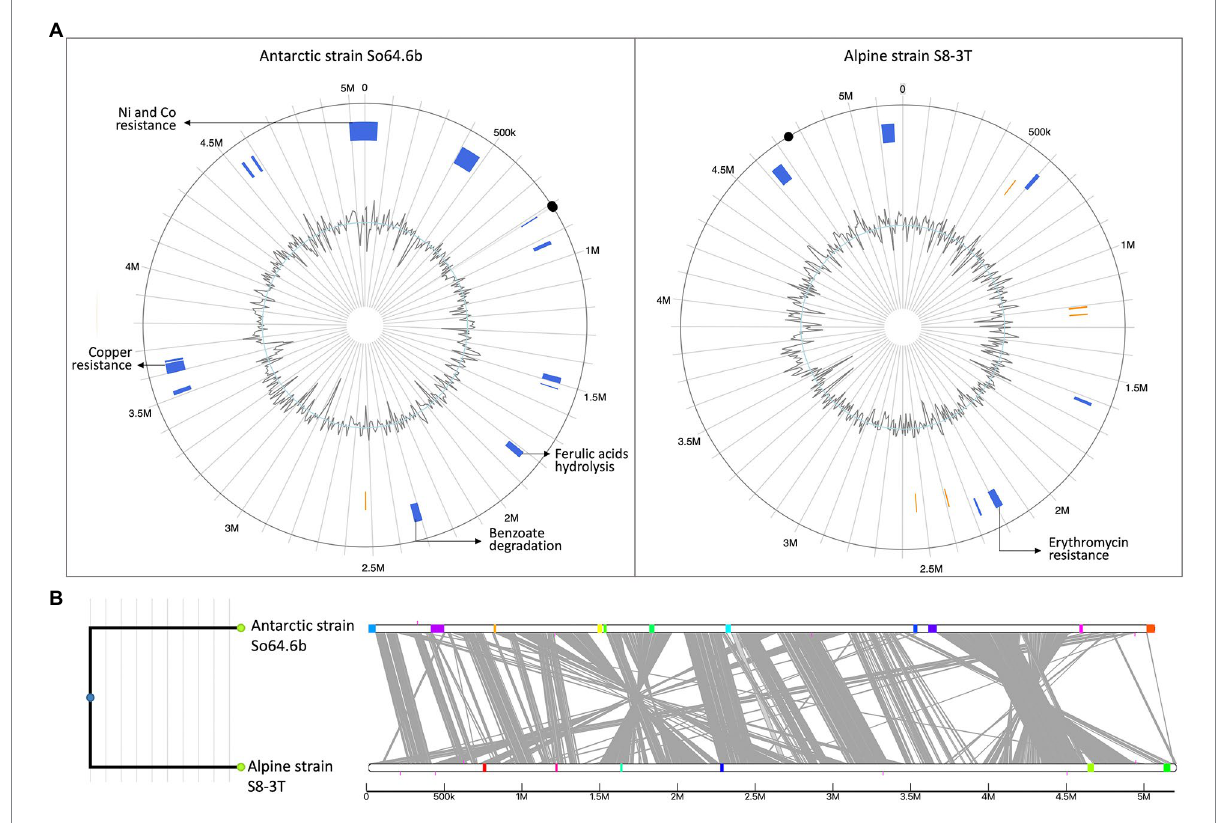
FIGURE 6 Genomic island (GIs) predictions and locations in two Sphingomonas genomes. (A) GI predictions using Island Viewer 4 and the two circular genomes of Antarctic Sphingomonas strain So64.6b (left) and Alpine strains S. alpina S8-3T (right). The circle represents a single chromosome, within the circle, GIs predictions are marked as colored blocks according to the prediction method; IslandPath-DIMOB (blue) and SIGI-HMM (orange). Evidence of genes related with adaptability, metabolism or resistances are described on pointing arrows. Inner line shows the change in GC skew. Black dots mark the OriC, predicted by proximity with recA , rnpA and dnaA and verified with Ori-Finder tool (Dong et al., 2022). (B) Comparative genomics visualization the Sphingomonas genomes. GIs are represented as coloured blocks placed on a linear representation of the genome (linear white bars indicate genomes, with alignments between genomes shown in grey). Same color represents matching